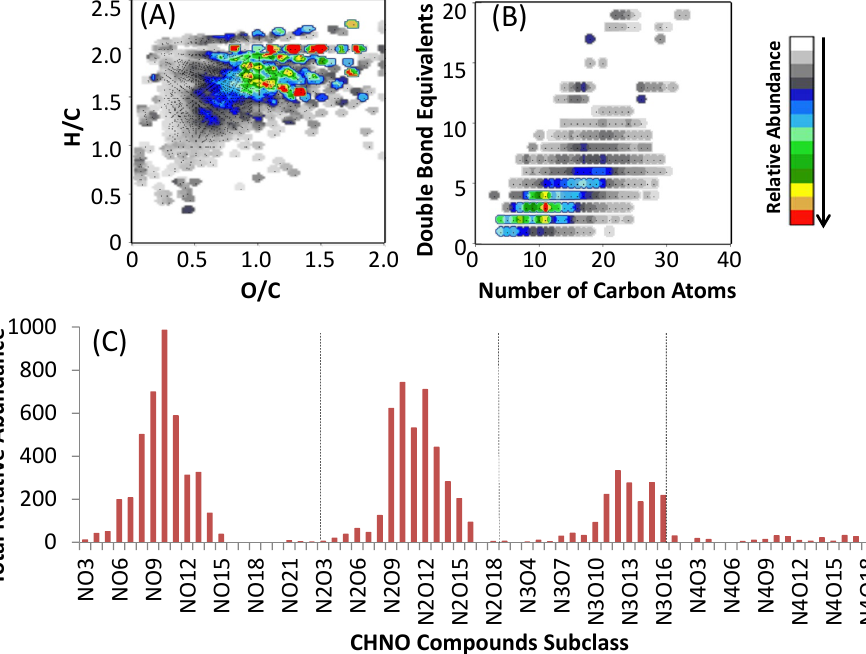
Fig. 5. Isoabundance van Krevelen diagram for CW1 CHNO compounds (a) . Isoabundance plot of DBE vs. number of carbon atoms in molecular formulas for CW1 CHNO compounds (b) . Total relative abundance (RA) of each subclass for CW1 CHNO compounds; the dashed lines separate the subclasses by number of nitrogen atoms contained in the formulas (c) . The corresponding figures for CW2 CHNO compounds are shown in Fig.